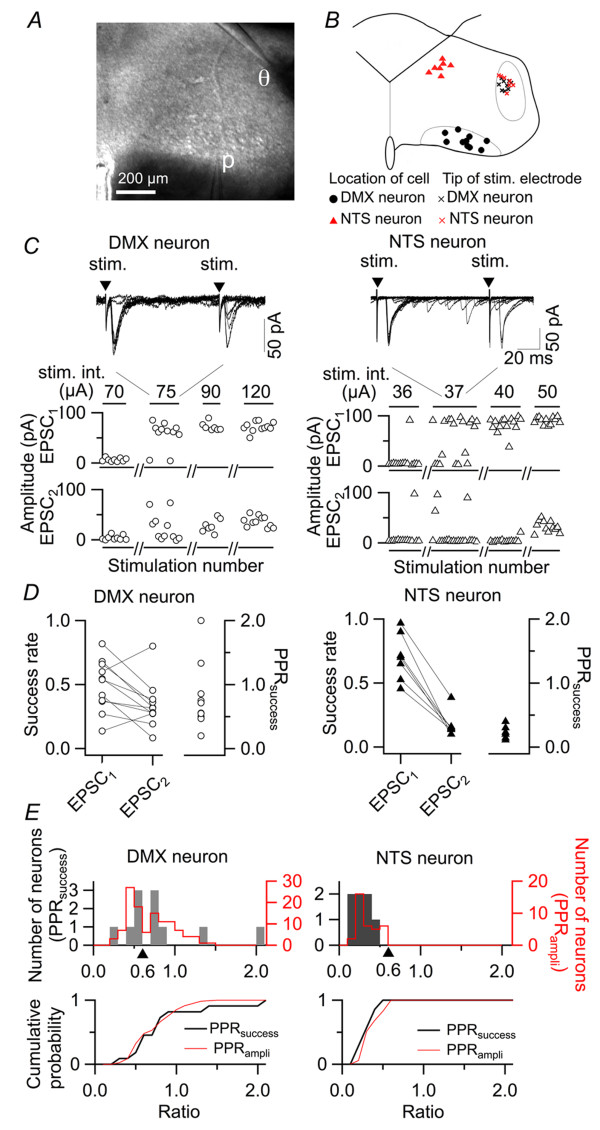
Minimal stimulation demonstrated the monosynaptic nature of the TS-DMX and TS-dm-cNTS (NTS) transmission. A, IR-DIC microphotograph showing the locations of a theta pipette bipolar electrode (θ) on the TS and recording pipette (p) in the DMX. B, summary of the location of the tip of the theta pipette bipolar electrode and recorded neurons. sfEPSC responses were recorded in the dm-cNTS (n = 7) and DMX (n = 11) neurons. The neurons shown here are not included in Fig. 1D. C, representative traces of sfEPSC in a DMX (left) and a dm-cNTS (right) neuron. Top, superimposed traces of EPSC waveforms that were evoked by minimal paired-pulse stimulation (arrowheads). The stimulation intensity was 75 μA for the DMX neuron and 37 μA for the dm-cNTS neuron. The plots on the bottom show the amplitude of sfEPSC1 and sfEPSC2 while increasing the stimulation intensity from one that evoked only failure responses to one that evoked mostly successful responses with only rare failures. D, success rate (defined as the ratio of non-failure events per trial) of EPSC1 and EPSC2 responses (the left-side ordinate) and PPRsuccess (defined as the success rate of sfEPSC2 normalized by that of sfEPSC1; right-side ordinate) in the 8 DMX (left; open circles) and 7 dm-cNTS (right; filled triangles) neurons. E, histograms (top) showing the distribution of PPRsuccess (filled gray bar; based on the sfEPSC recordings with minimal stimulation) and PPRampli (the PPR estimated based on the amplitude ratio of EPSC1 and EPSC2 with submaximal stimulation; the same histograms shown in Fig. 1C) in DMX (left) and dm-cNTS (right) neurons, respectively. Cumulative probability curves (bottom) produced based on the histograms above. No significant difference was detected between the distributions of PPRampli and PPRsuccess in either DMX (p = 0.95) or dm-cNTS neurons (p = 0.40). Kolmogorov-Smirnov test.